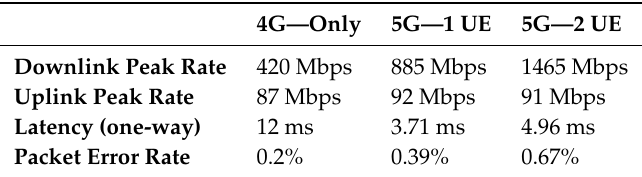
Table 3. Aggregated (median) results of comparative measurements [23].